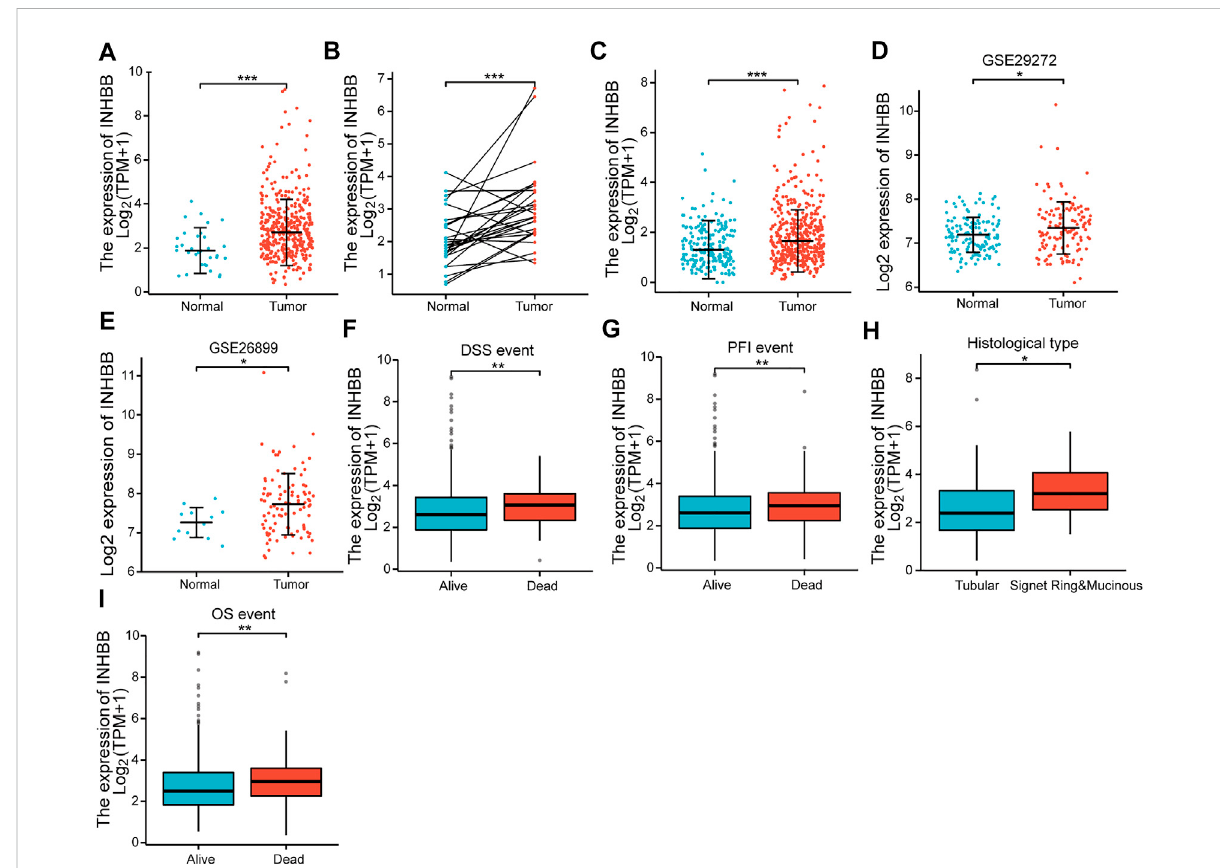
FIGURE 1 TheexpressionofINHBBin (A) GCtissuesandnormaltissuesdatafromTCGA, (B)